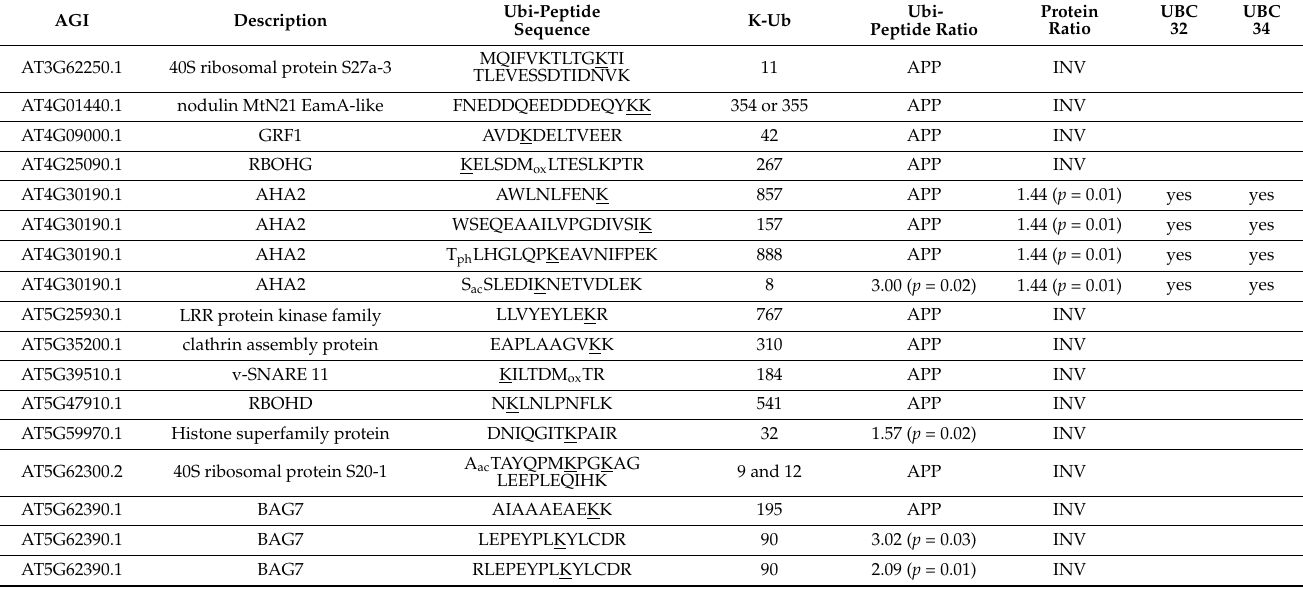
The table describes proteins for which protein and ubiquitin peptide quantification data are available. Columns 1 and 2: AGI and protein name. Column 3: the ubiquitinated residue is underlined. ox: oxidation; ac: acetylation; ph: phosphorylation. Column 4: K-Ub position in the protein. Column 5: the quantitative ratio of the ubiquitinated peptide between mannitol and control experiments, with the associated p -value. APP: appearance; DISP: disap- pearance. Column 6: the protein quantitative ratio between mannitol and control experiments, with the associated p -value. INV: invariant protein. Columns 7 and 8: protein interaction with UBC32 and UBC34 [15,16]. *: